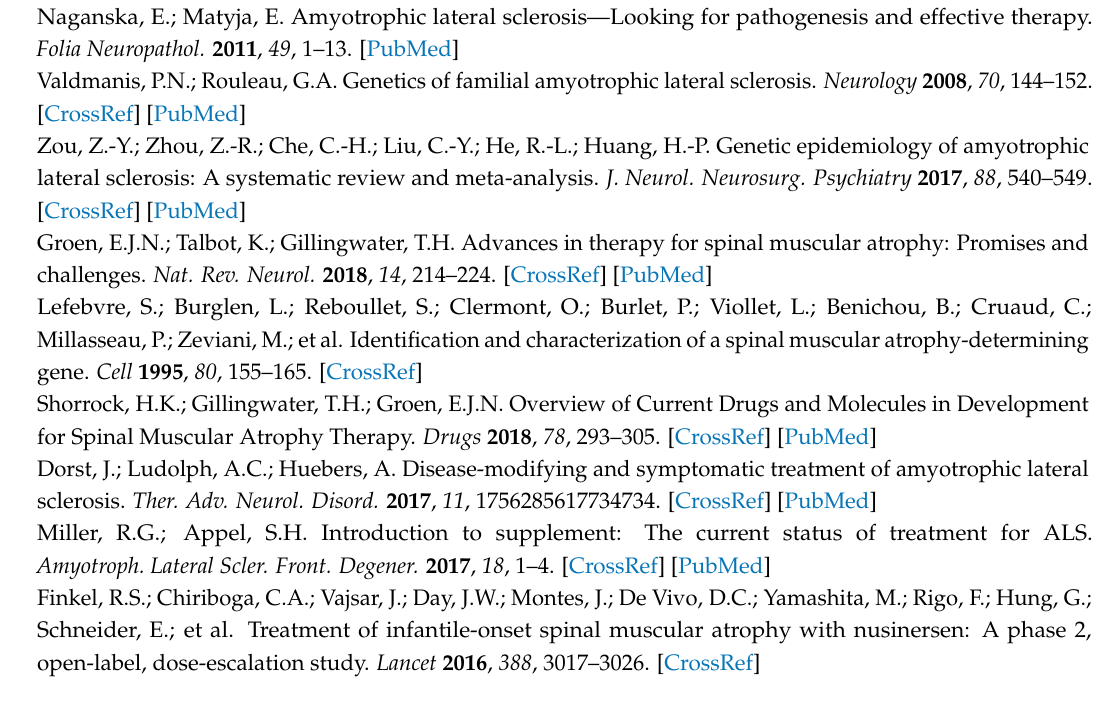
Table S1: ALS proteomic studies used in the comparison, Table S2. Proteins differentially expressed in the same direction in biofluids from ALS patients, Table S3. Proteins that showed contradictory direction of differential expression in biofluids from ALS patients across at least two proteomic studies, Figure S1. Bioinformatics analysis of eleven proteins that showed consistent change in expression in biofluids from ALS patients, Table S4. Proteins that showed consistent direction of differential expression in ALS cells and tissues across two or more proteomic studies, Table S5. Proteins that showed contradictory direction of differential expression in cells and tissues across two or more proteomic studies of ALS, Table S6. GO term analysis of proteins that were differentially expressed in tissues and cells in ALS proteomic studies, Table S7. GO term analysis of proteins that were differentially expressed in SMA and ALS proteomic